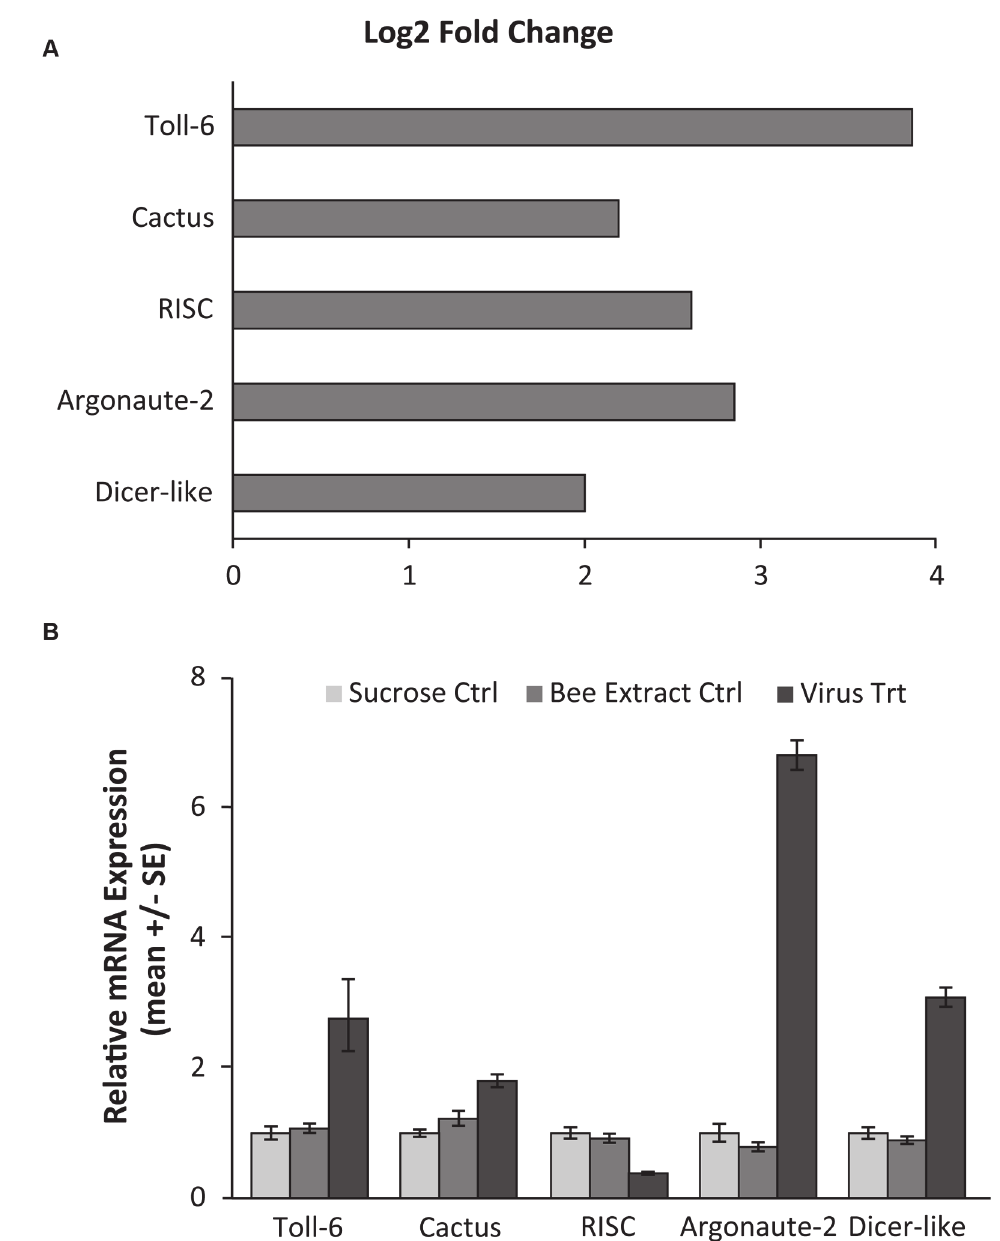
Fig 2. Validation of RNA-seq results for genes in RNAi and Toll pathways. A) RNA-seq results, demonstrating the log 2 fold change (expression in infected vs control groups) of three genes from the RNAi pathway, which has been shown to be used in antiviral responses in Drosophila, as well as two genes from the Toll pathway that have been hypothesized to be implicated in antiviral defense. The log fold change was calculated using the DESeq package in R. B) qRT-PCR confirmation of the gene expression in separate bee samples fed either 50% sucrose solution (Sucrose Ctrl), bee extract from individuals with no IAPV infection (Bee Extract Ctrl), and bee extract from individuals with confirmed IAPV infection (Virus Trt)(ANOVA with Tukey HSD posthoc analysis; n = 10 bees/group). Accession numbers and primer sequences can be found in S1B